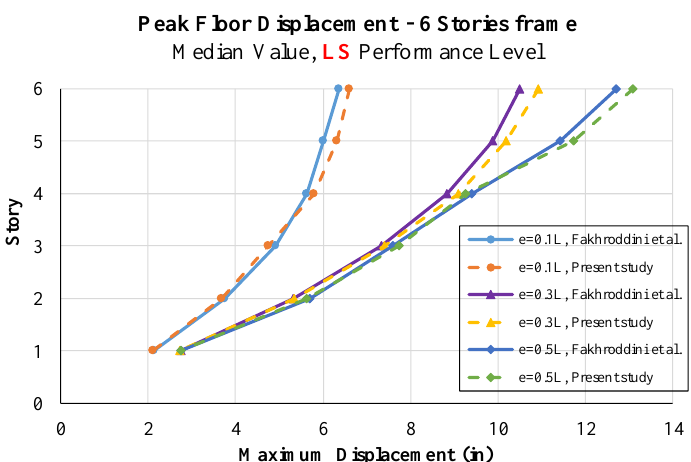
Figure 5. Model validation in comparison with the result of Fakhroddini et al . (Fakhraddini et al . , 2019)